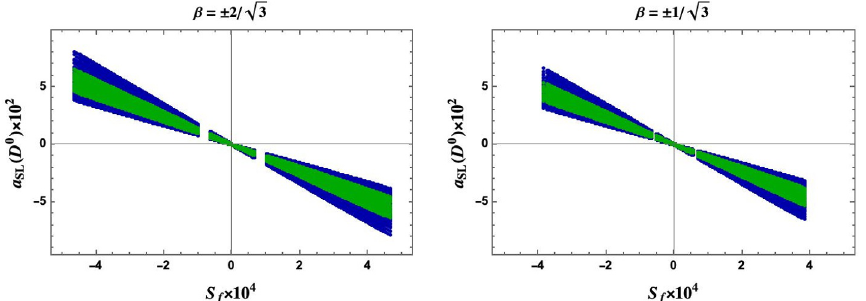
Figure 3 . Correlation between the asymmetry S f (for η f = +1 ) and the semileptonic asymmetry a SL ( D 0 ) eqs. (3.27), (3.28) in 331 models with parameters as in figure 2. The green (blue) region corresponds to the mixing observables x and y within 1 σ (2 σ ) in the experimental range in D D